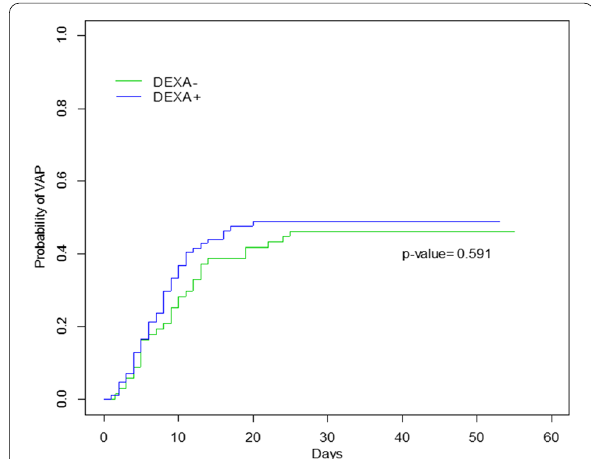
p values in bold were considered statistically significant Data are presented as median and interquartile range or absolute value and percentage